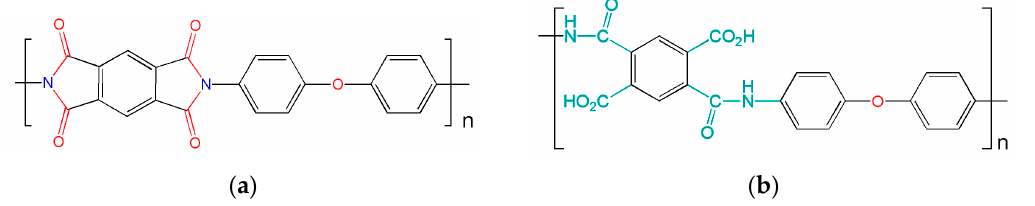
Figure 1. ( a ) Structural diagram of a polyimide molecule; ( b ) the most probable pattern of surface bond formation after the influence of ozone and heating temperature.